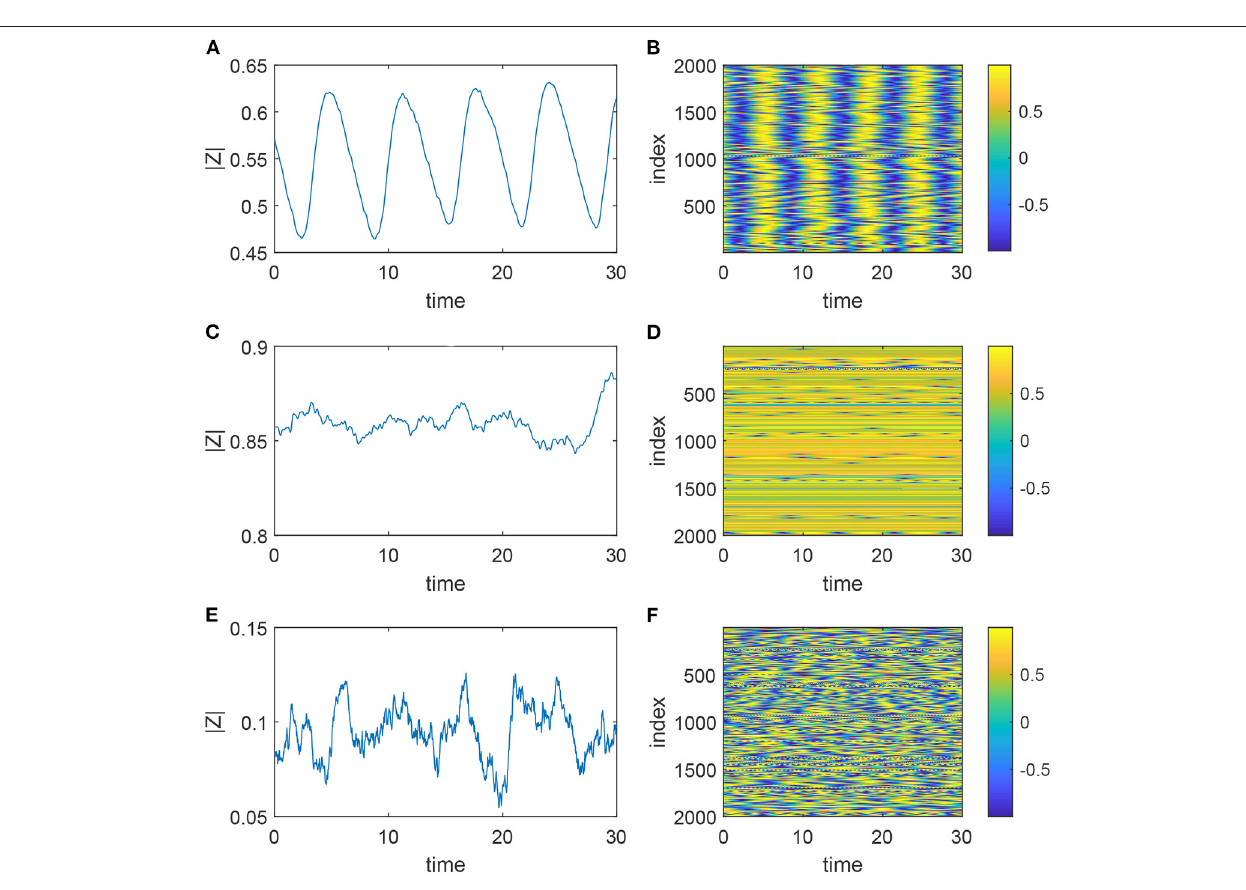
FIGURE 3 | Dynamics of the system (1) with uncorrelated degrees. (A,B) Correspond to ( ǫ , 1 ) to ( ǫ , 1 ) (0.2,0.5) (asynchronous states). The left panels show the magnitude of the global order parameter, and the right show sin θ j . Other parameters: = ω 0 1, β 0, m 100, M 400, N = = = = =